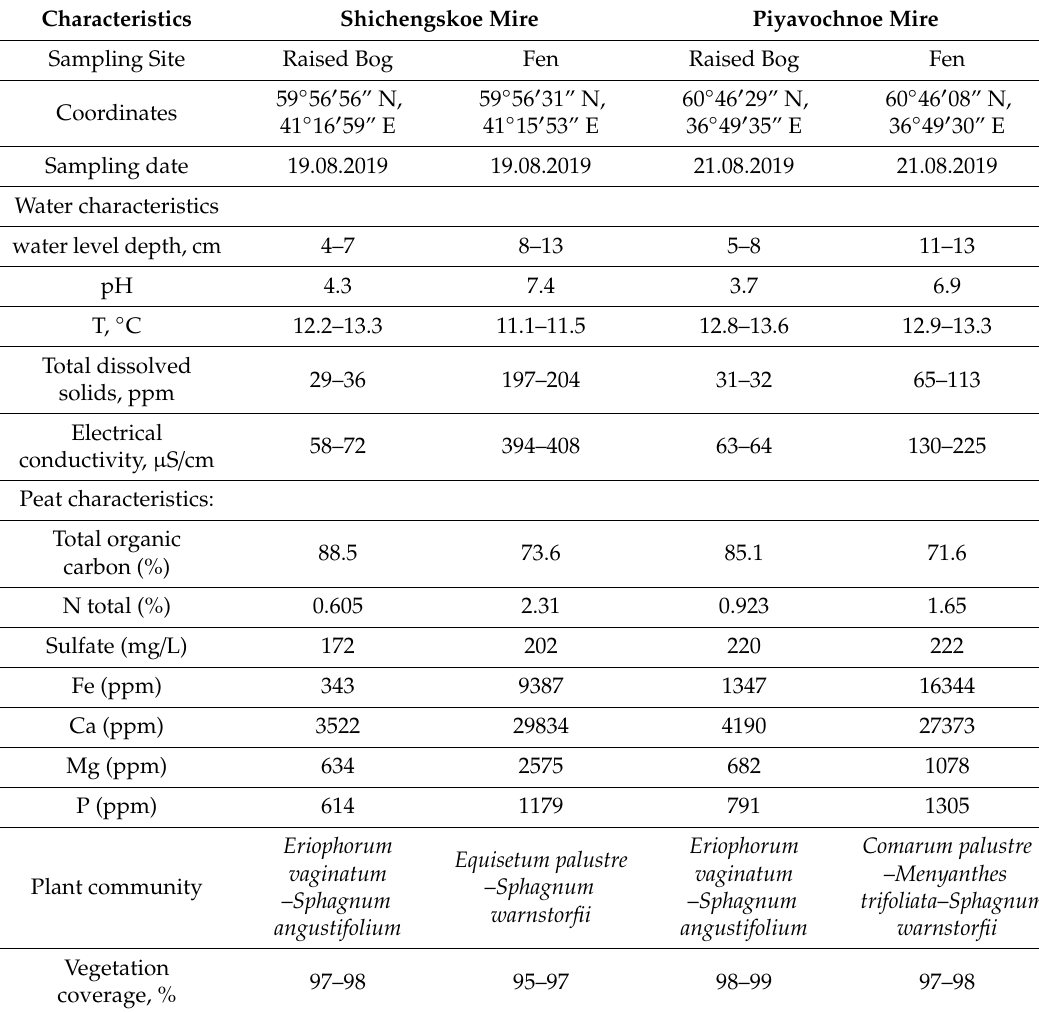
Table 1. Characteristics of the sampling